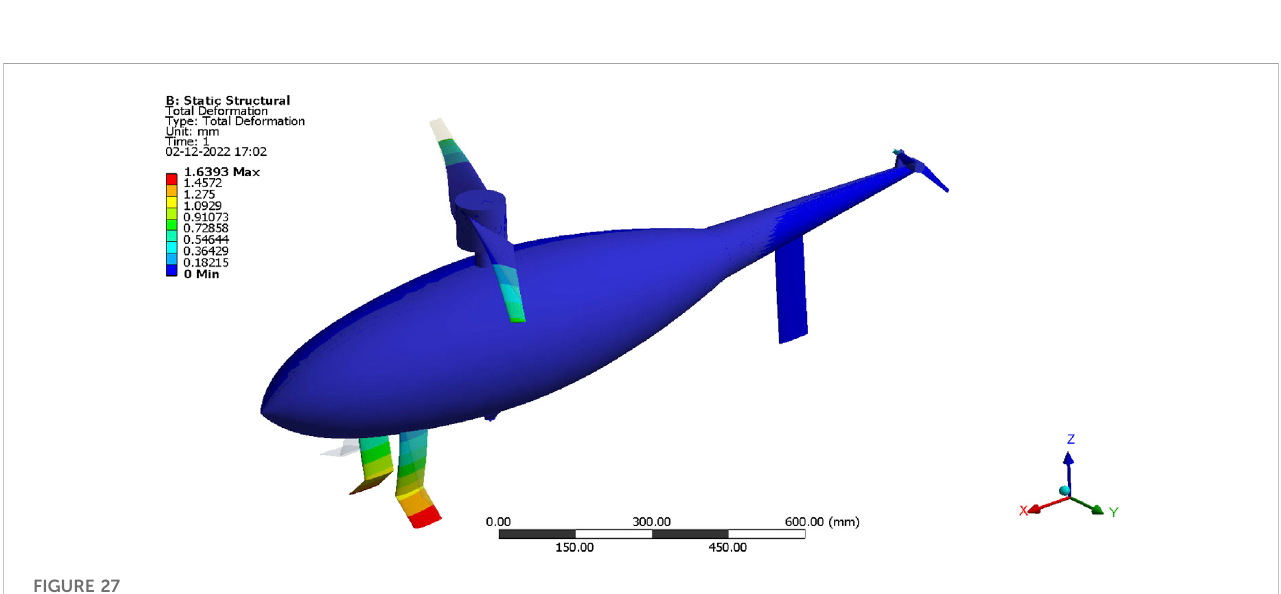
CFRP-woven-prepreg – Total